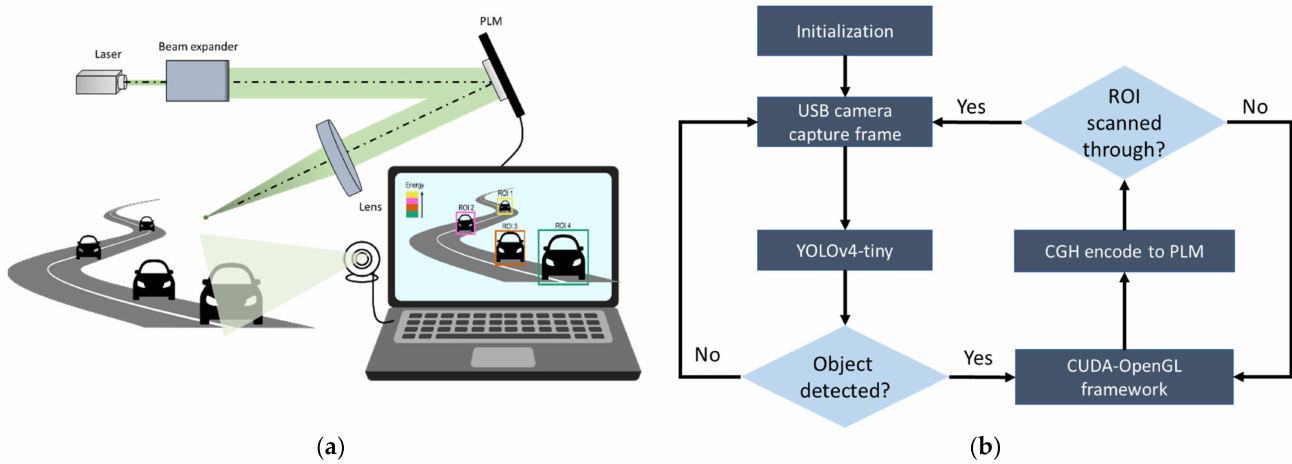
Figure 5. ( a ) The system of adaptive beam steering. Multiple regions of interest (ROIs) are captured by camera. ( b ) Workflow of adaptive beam steering. Camera-based rough order of magnitude (ROM) detection of the relative size of objects. For example, the relative appearance of multiple cars indicates the relative distance of multiple ROIs.